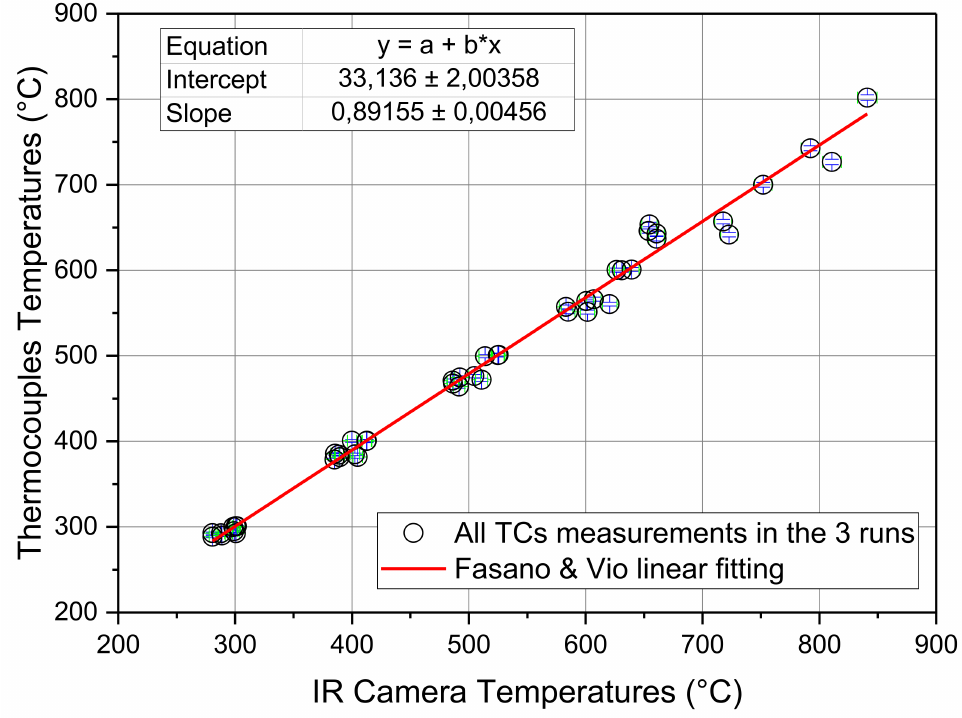
Figure 7. Fasano and Vio [8] fit of the IR camera measurements and the W-slab